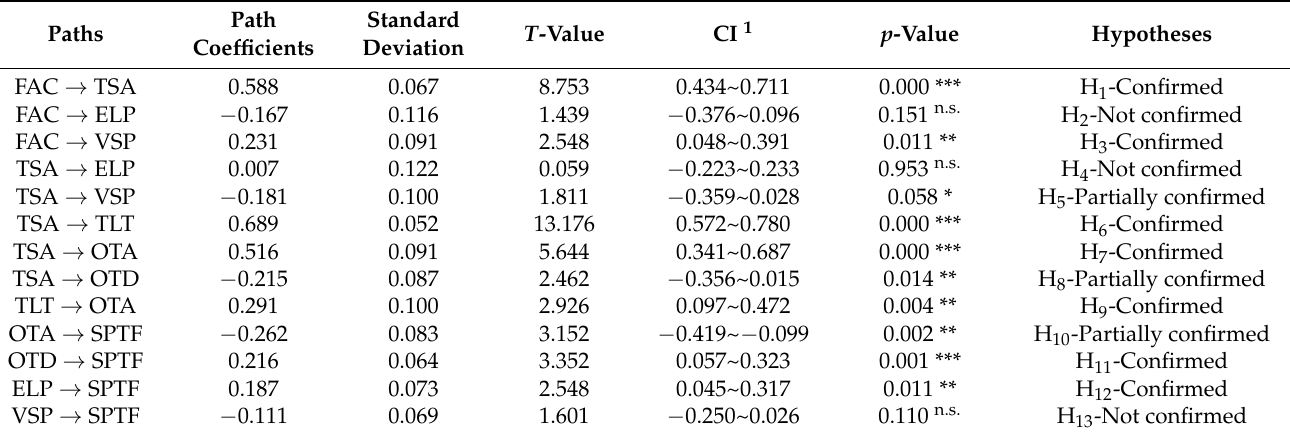
Table 4. The path coefficients of the structural equation